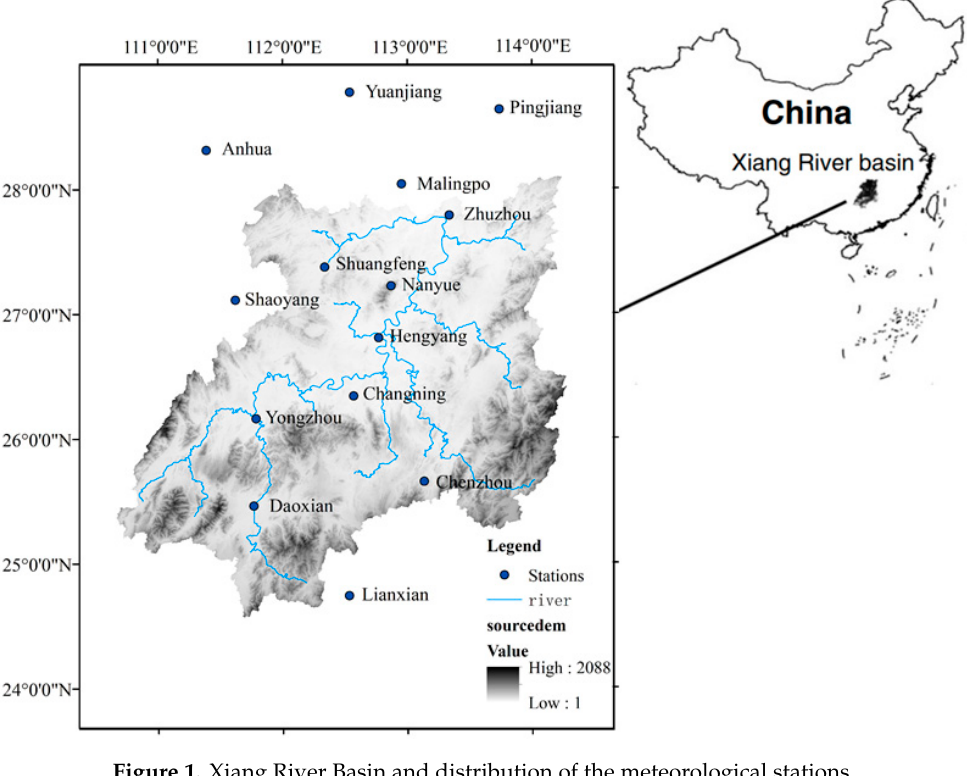
Figure 1. Xiang River Basin and distribution of the meteorological stations.